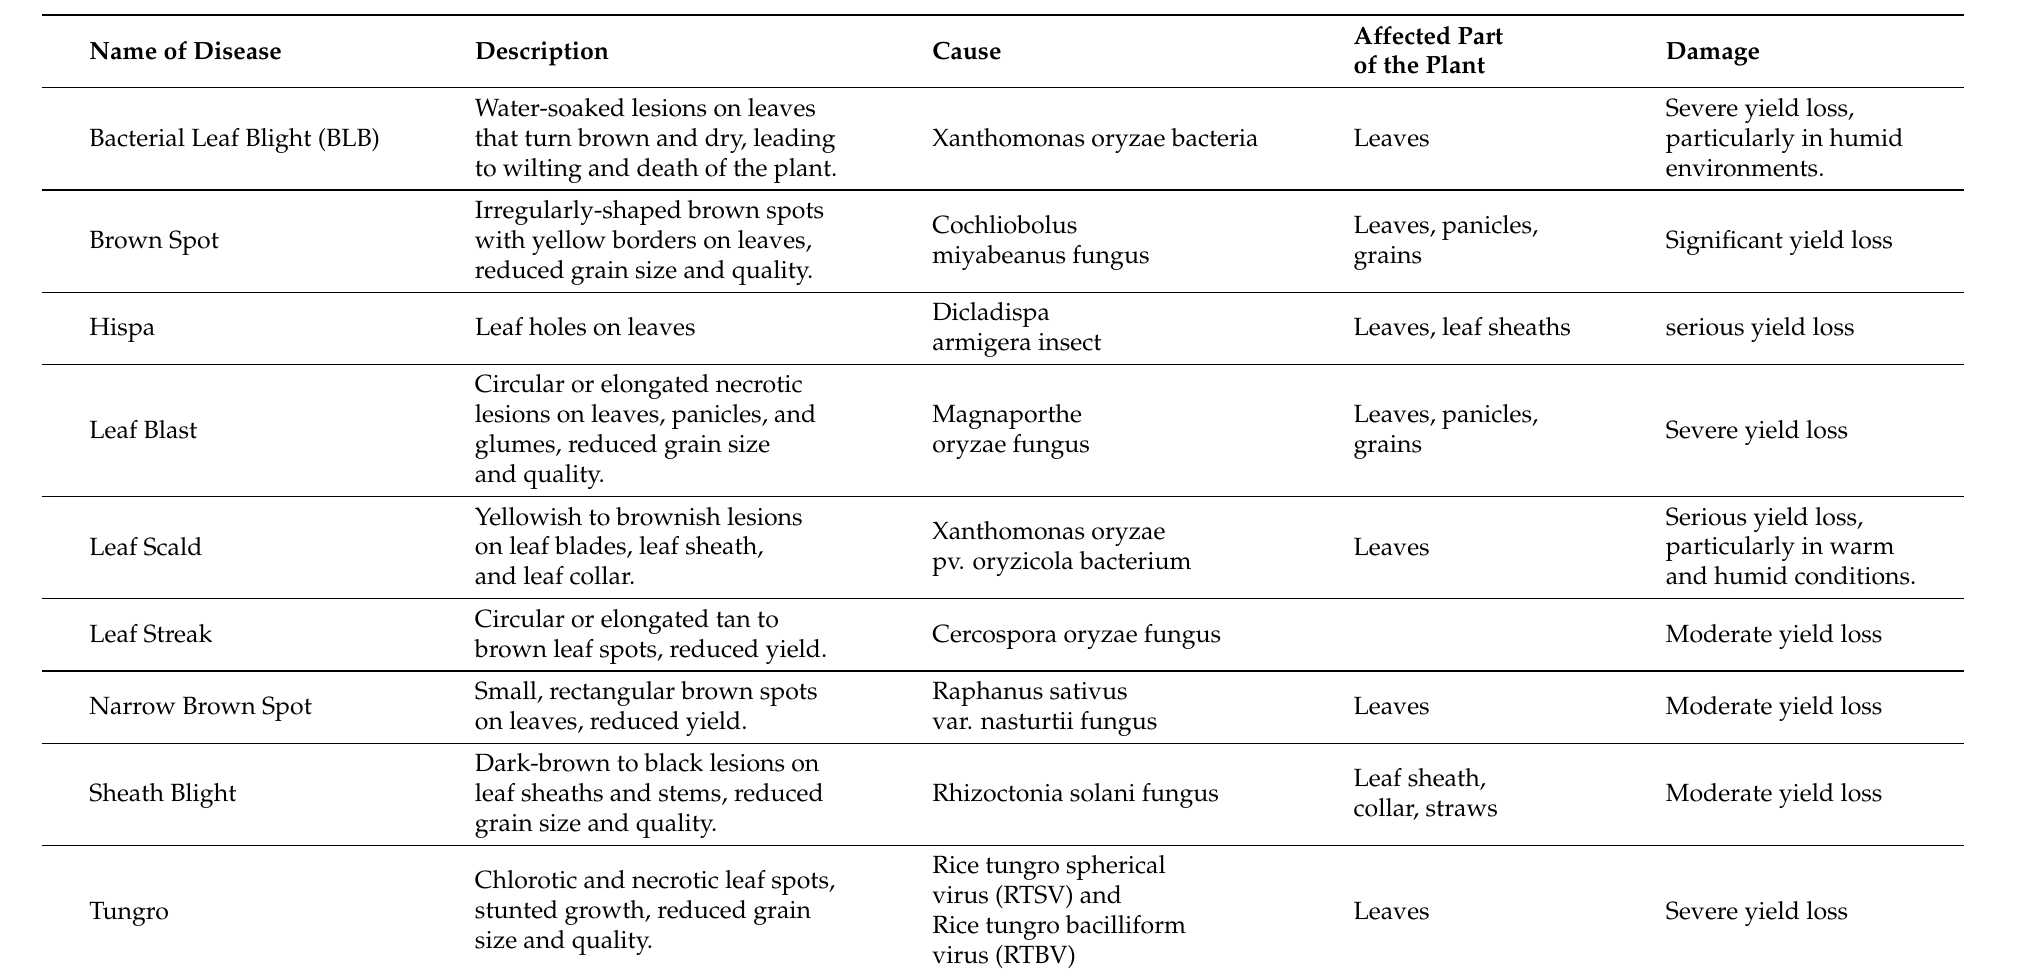
Table 1. List of Rice leaf diseases, their symptoms, and their